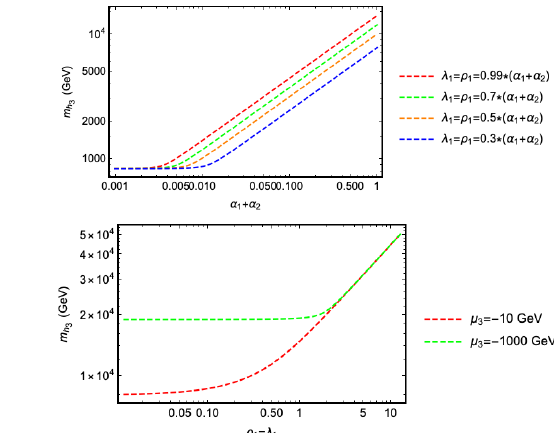
Higgs mass as a 2